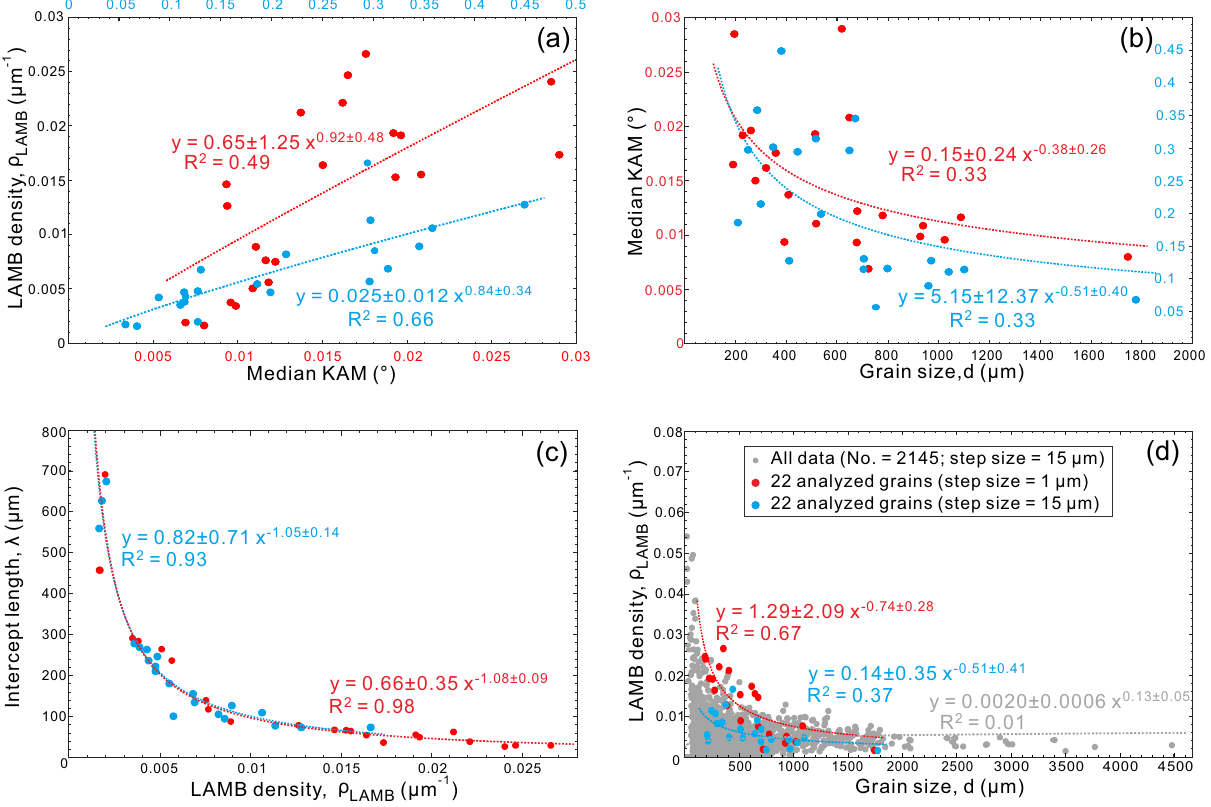
Figure 8. ( a ) LAMB density versus median KAM, ( b ) median KAM versus grain size, ( c ) intercept length vs. LAMB density and ( d ) LAMB density versus grain size. Since grain-3 has only one LAMB at the step size of 15 μm, its intercept length cannot be calculated and excluded in ( c ). The colors of the fitting curves and the fitting equation correspond to the colors of